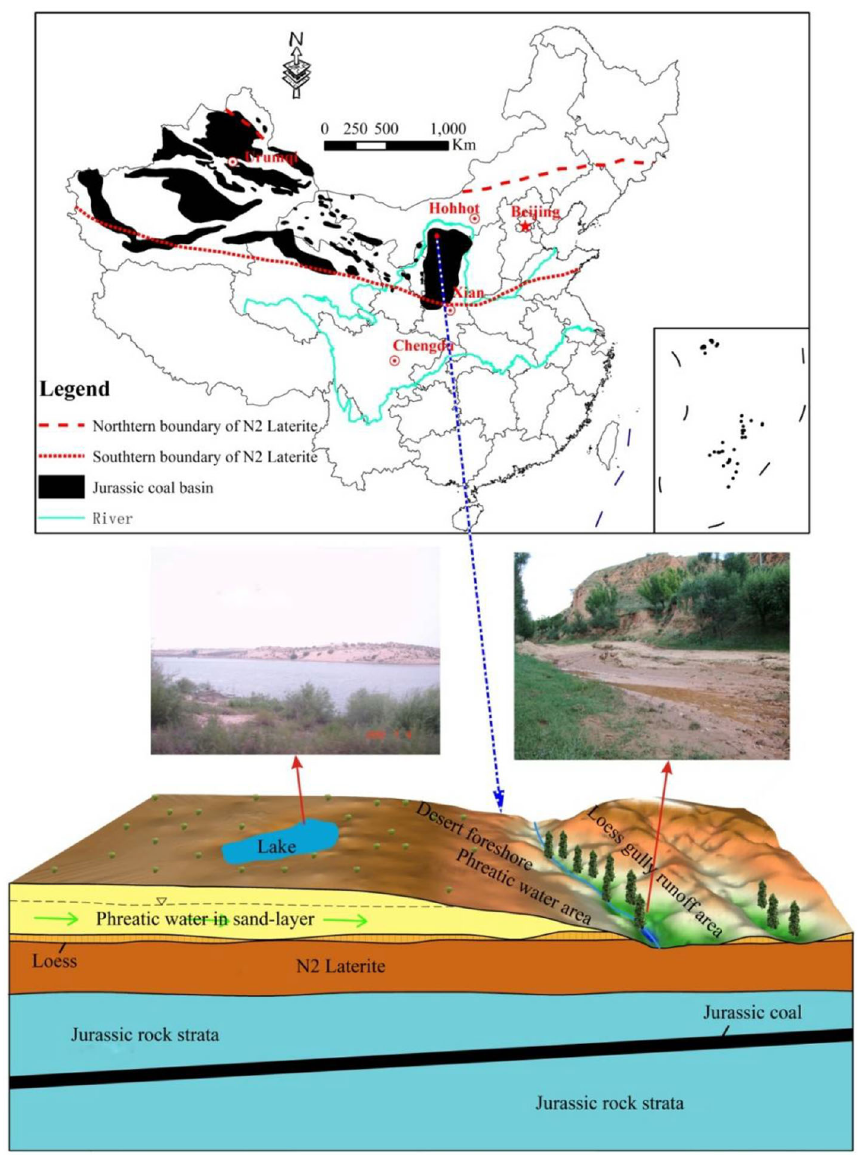
Fig. 1 Spatial relationship schematics for Chinese Jurassic coalfield distribution and Jurassic coal seams in research areas, as well as N 2 laterite aquifuge layer and shallow surface